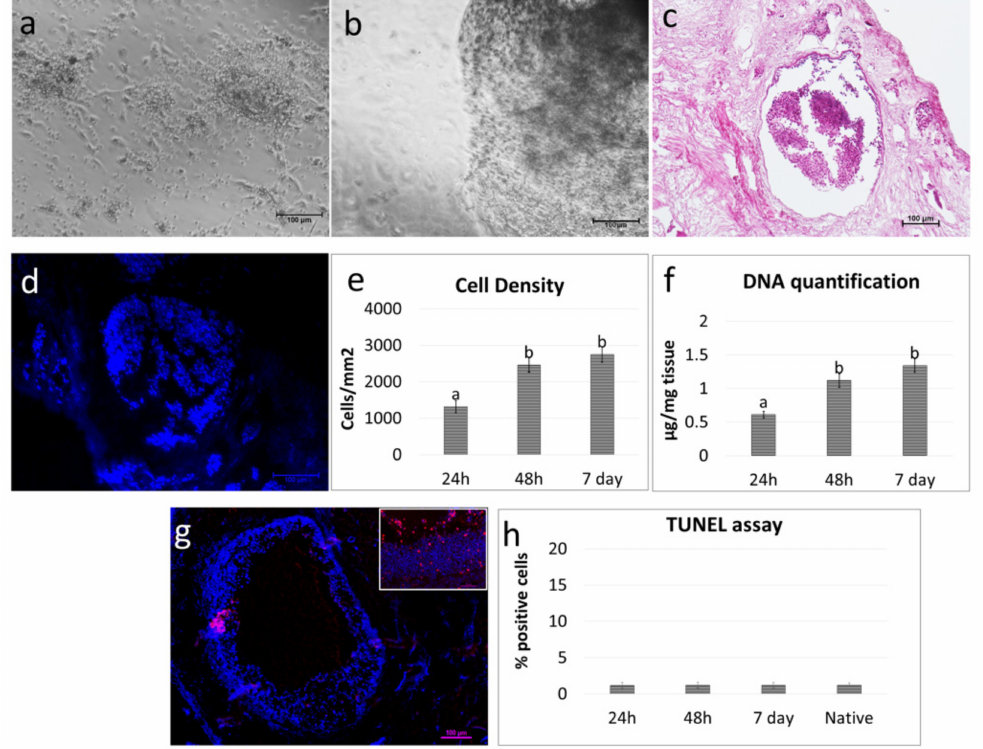
Figure 4. Repopulation of decellularized ovarian ECM-based scaffolds with pOCs. ( a ) Image illustrating freshly isolated pOCs. Scale bar = 100 µ m. ( b ) pOCs adhered and migrated into the decellularized ECM-based ovarian scaffolds. Rep- resentative image after 7 days of culture. Scale bar = 100 µ m. ( c ) H & E staining demonstrated the presence of pOCs in the ECM-based scaffolds. Scale bar = 100 µ m. ( d ) DAPI staining confirmed the positivity for nuclei. Scale bar = 100 µ m. ( e ) Cell density analysis showed ECM-based scaffolds’ repopulation after 24 h, with a higher number of cells after 48 h and 7 days of coculture. Data are expressed as the mean ± the standard error of the mean (SEM). a and b indicate statistically significant differences ( p < 0.05). ( f ) DNA quantification demonstrated the presence of pOCs into the ECM-based scaffolds after 24 h, with an increasing cell number at 48 h, which was steadily maintained at Day 7. Data are expressed as the mean ± the standard error of the mean (SEM). a and b indicate statistically significant differences ( p < 0.05). ( g ) Representative picture of the TUNEL assay showing positive cells in red. Nuclei were stained with DAPI (blue). Scale bars = 100 µ m and 50 µ m. ( h ) TUNEL-positive cell rates detected 24–48 hours and 7 days postseeding were comparable to those identified in the native tissues (native). Data are expressed as the mean ± the standard error of the mean